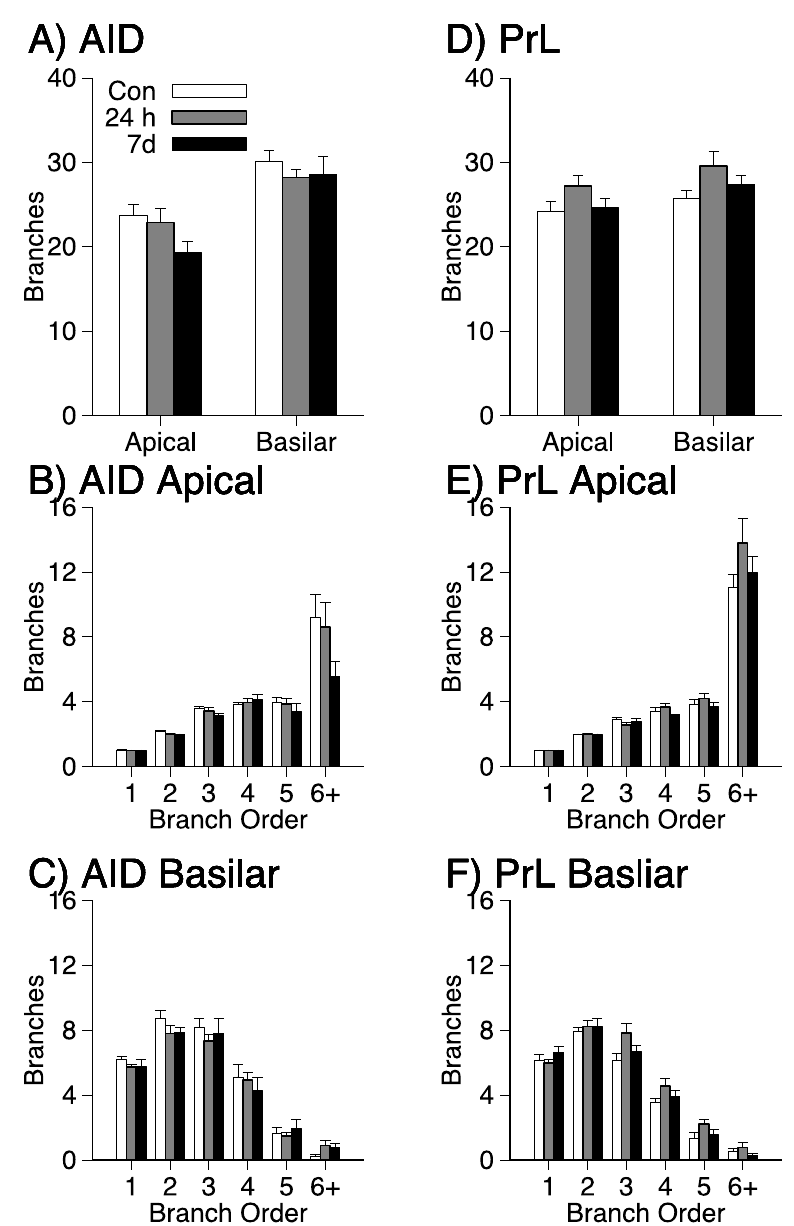
Figure 5. AID ( A – C ) mean ( + SEM) branch counts in apical and basilar fields (A), mean ( ± SEM) branch counts for each branch order for apical ( B ) and basilar ( C ) fields; PrL ( D – F ) mean ( + SEM) branch counts in apical and basilar fields ( D ), mean ( ± SEM) branch counts for each branch order for apical ( E ) and basilar ( F ) fields.